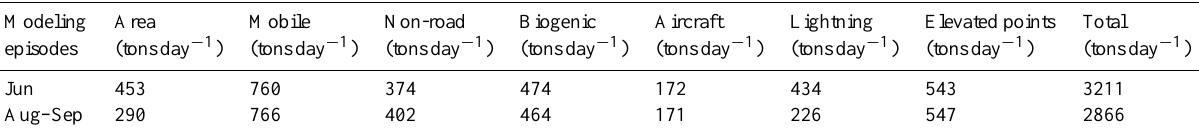
Table 1. Categorized a priori NO x emission rates in inversion region for two modeling episodes.